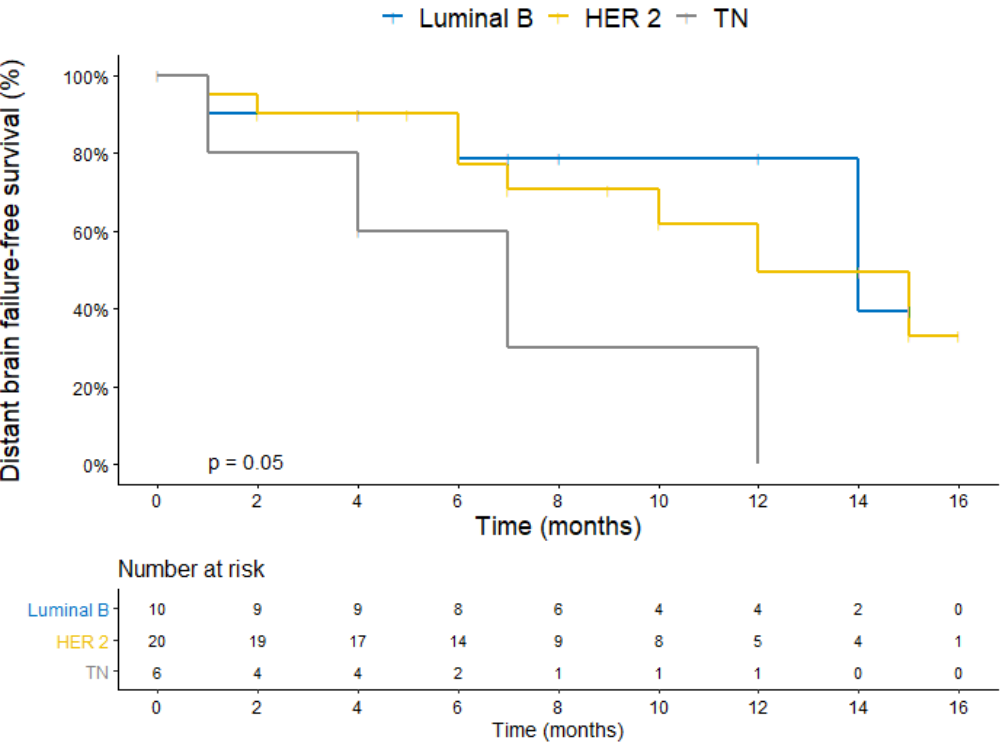
Figure 2. Kaplan – Meier plot for distant brain failure-free survival stratified by the primary immuno- Figure 2. Kaplan–Meier plot for distant brain failure-free survival stratified by the primary im- phenotype.